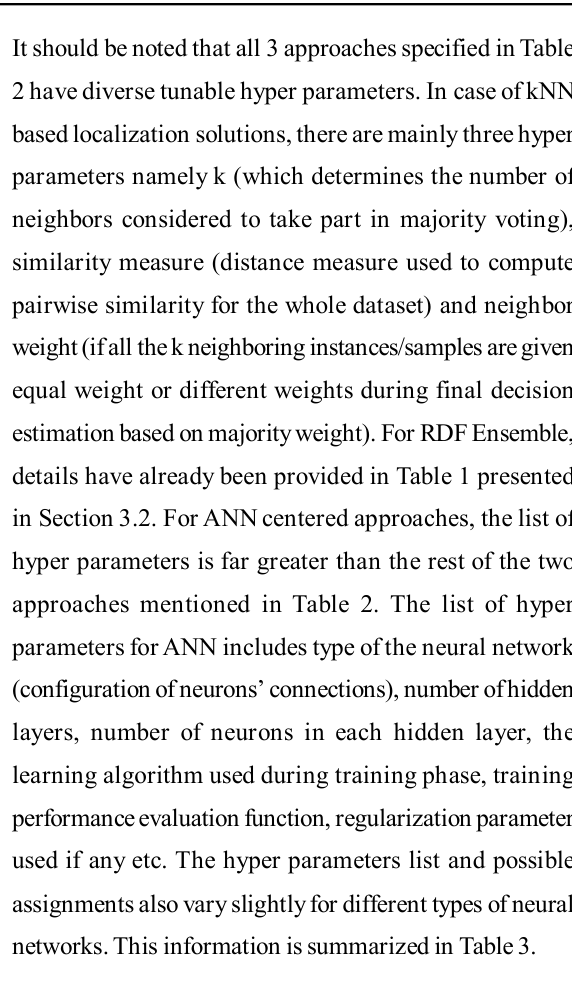
TABLE 3. HYPER PARAMETERS REQUIRED BY ALL THREE